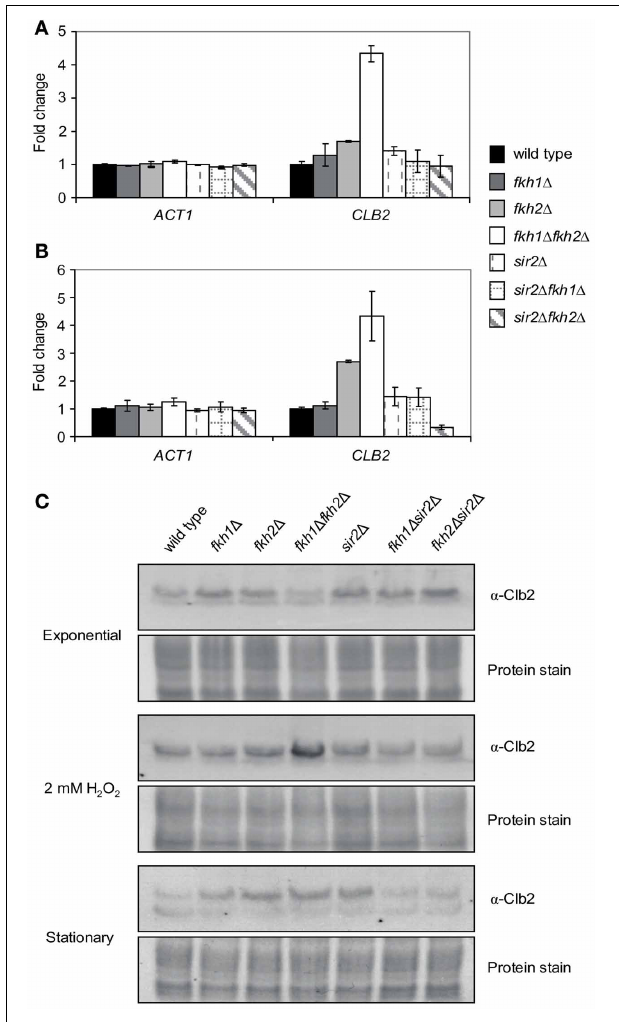
FIGURE 6 | CLB2 transcript and protein levels are altered under stress conditions. (A,B) Quantitative Real-Time PCR. Total RNA was prepared from exponentially growing wild type and fkh1 (cid:2) , fkh2 (cid:2) , fkh1 (cid:2) fkh2 (cid:2) , sir2 (cid:2) , fkh1 (cid:2) sir2 (cid:2) , and fkh2 (cid:2) sir2 (cid:2) cells (OD 600 ∼ 0 . 6) that were treated with 2mM H 2 O 2 for 90min (A) or grown to stationary phase (OD 600 ∼ 1 . 6) (B) . The ACT1 gene was used as control. Each bar represents the mean average obtained from three independentexperiments. (C) Protein extracts were isolated from exponential growing cells (OD 600 ∼ 0 . 6), cells incubated with 2mM H 2 O 2 for 90min or cells grown to stationary phase. Clb2 levels were determined by Western Blot using an α -Clb2 specific antibody. Coomassie Brilliant Blue protein staining was used as a loading